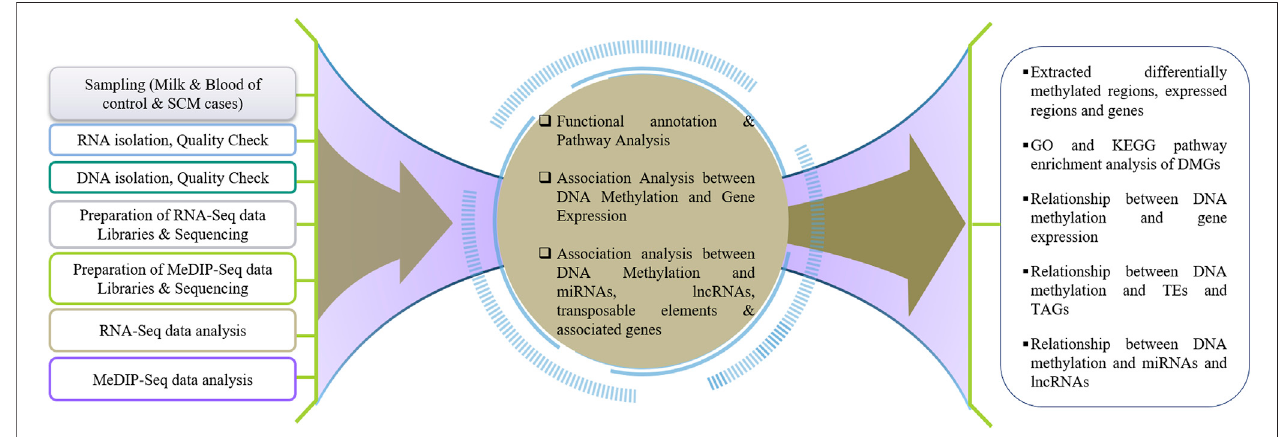
FIGURE 1 | Schematic work fl ow towards understanding the genome-wide DNA methylation and its effect on gene expression during SCM in water buffalo.